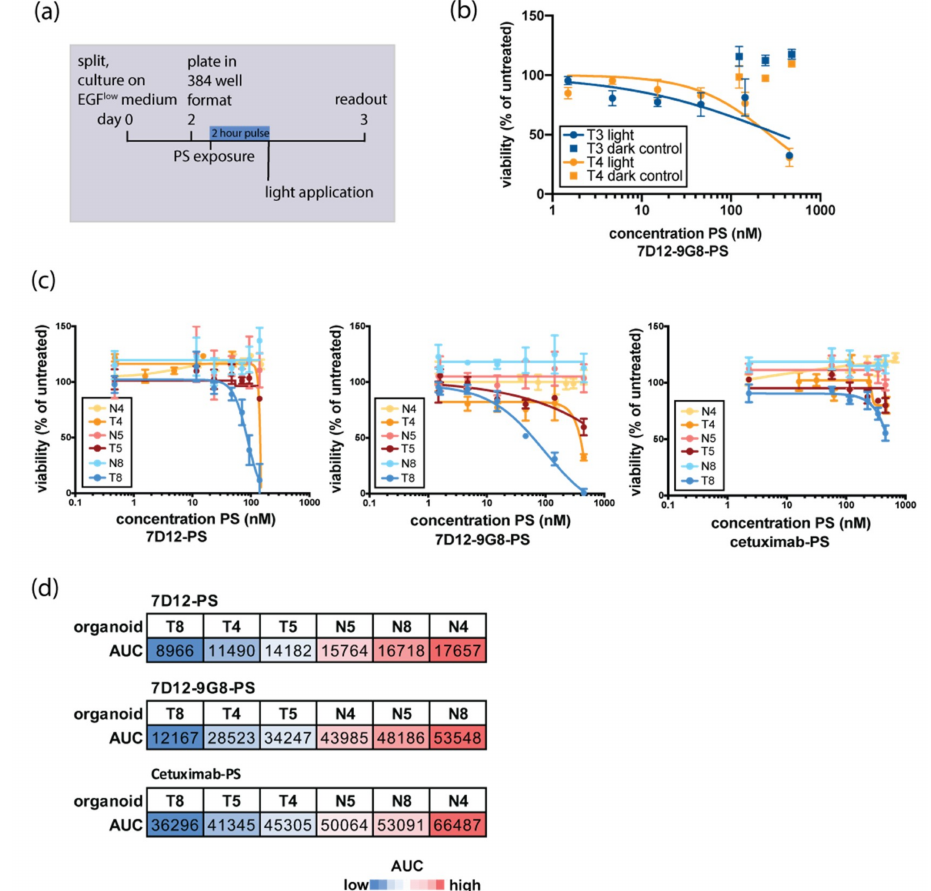
Figure 2. Organoid response to in vitro EGFR-targeted PDT is donor-dependent and tumor-specific. ( a ) Schematic outline of the experimental set-up of organoid in vitro PDT. Organoids are disrupted into single cells, recovered for two days on medium containing physiological EGF, and subsequently filtered, counted, and plated into a 384 well format. A two-hour exposure to EGFR-targeting nanobody-PS or antibody-PS conjugates was followed by a light-dose activating the PS. Twenty-four hours later, cell viability was assessed. ( b ) EGFR-targeting conjugates used in this study did not show toxicity without activation of the PS. Here, toxicity of 7D12-9G8 in T3 and T4 is shown as an example. ( c ) Response to EGFR-targeted PDT of matched normal and tumor organoid pairs. Response to 7D12-PS, 7D12-9G8-PS, and cetuximab-PS is shown for N4 and T4 (orange), N5 and T5 (red), and N8 and T8 (blue). Normal organoids are depicted in a lighter shade of the same color than their tumor counterparts. ( d ) Quantification of organoid response to EGFR-targeted PDT shown in Figure 2c Area under the curve (AUC) is used as a readout for response to EGFR-targeted PDT. Blue indicates low AUC-values (response to therapy), whereas red indicates high AUC values (no response to